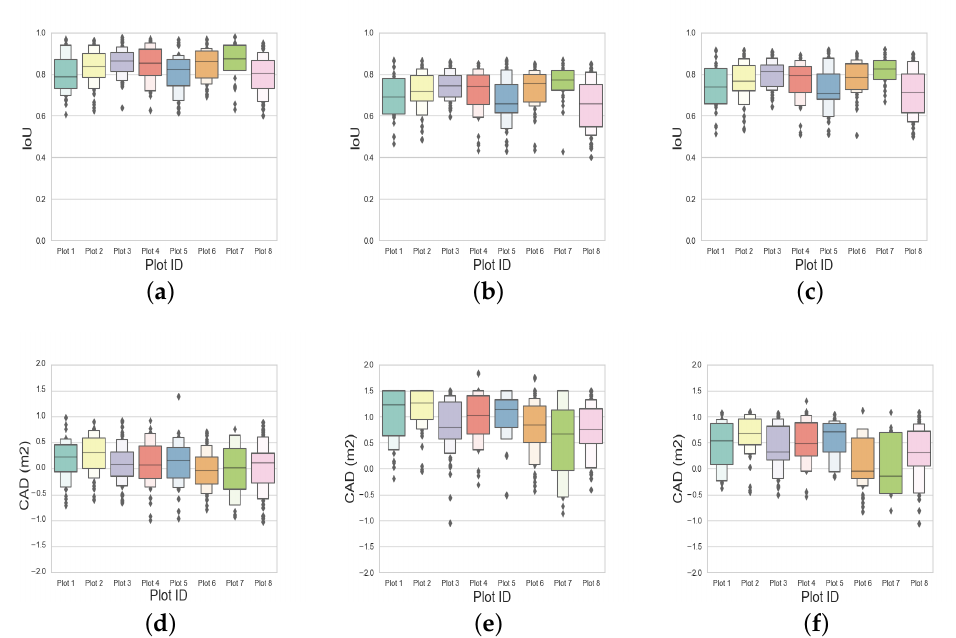
Figure 9. The intersection over union (IoU) and crown-area difference (CAD) distribution for all the trees in the eight circular plots are represented as boxplots for the spectral, spatial, and struc- tural information-based individual tree crown delineation ( a , d ), the marker-controlled watershed segmentation ( b , e ), and the bias-field segmentation algorithm ( c , f ),